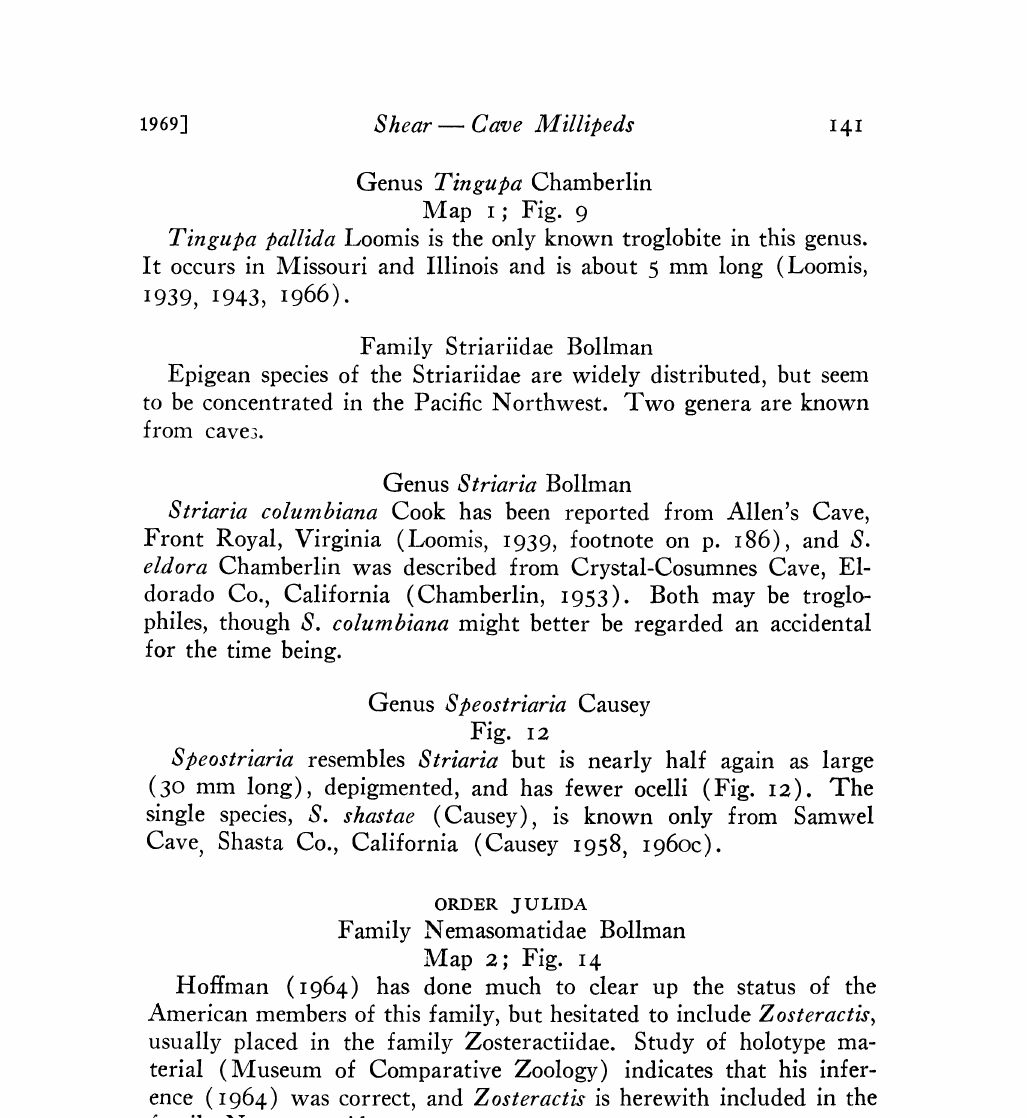
Fig. 14 The single species of this genus, Z. interminata Loomis, (Fig.